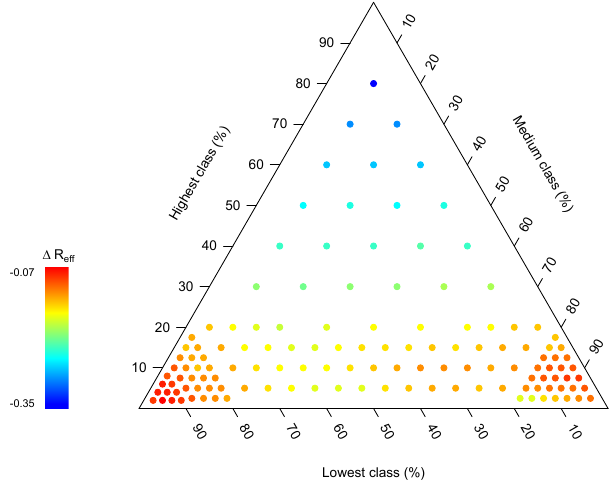
Figure 6. Median difference in model efficiency for models cali- brated with data for three water level classes and the upper bench- mark ( (cid:49)R eff ) for different class